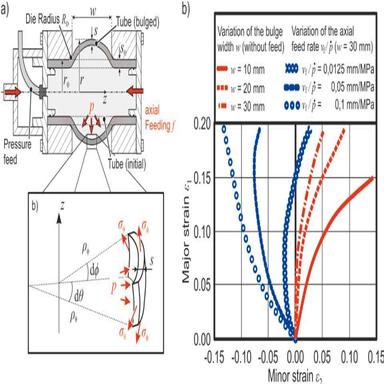
Fundamentals of the tube-bulge-test - a) Schematic of the test and stress-distribution in the pole of the specimen according to and b) exemplary influencing factors and effects on the strain path according to.